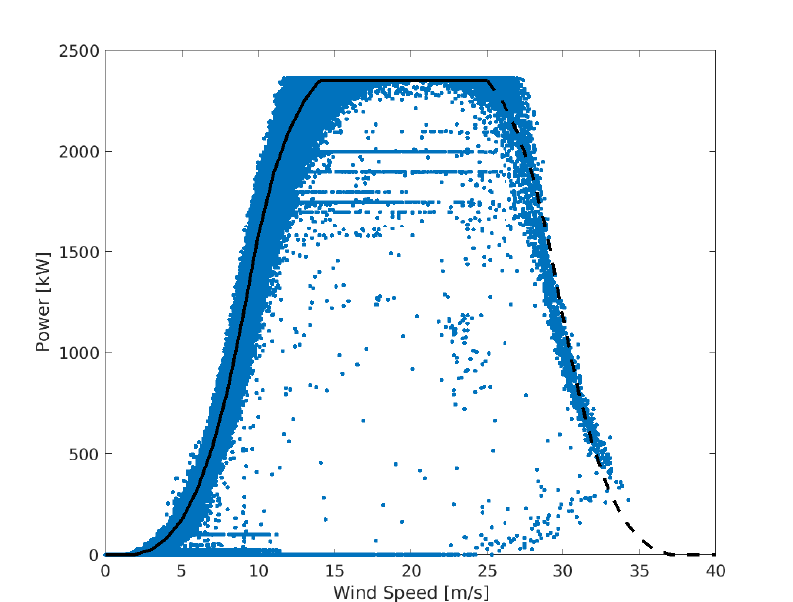
Figure 1. Plot of measured power vs. measured wind speed of all data points (blue dots) and power curve provided by constructor (black solid line). In the storm region ( v > 25m/s), the dashed curve represents the trend presumed by the constructor but not